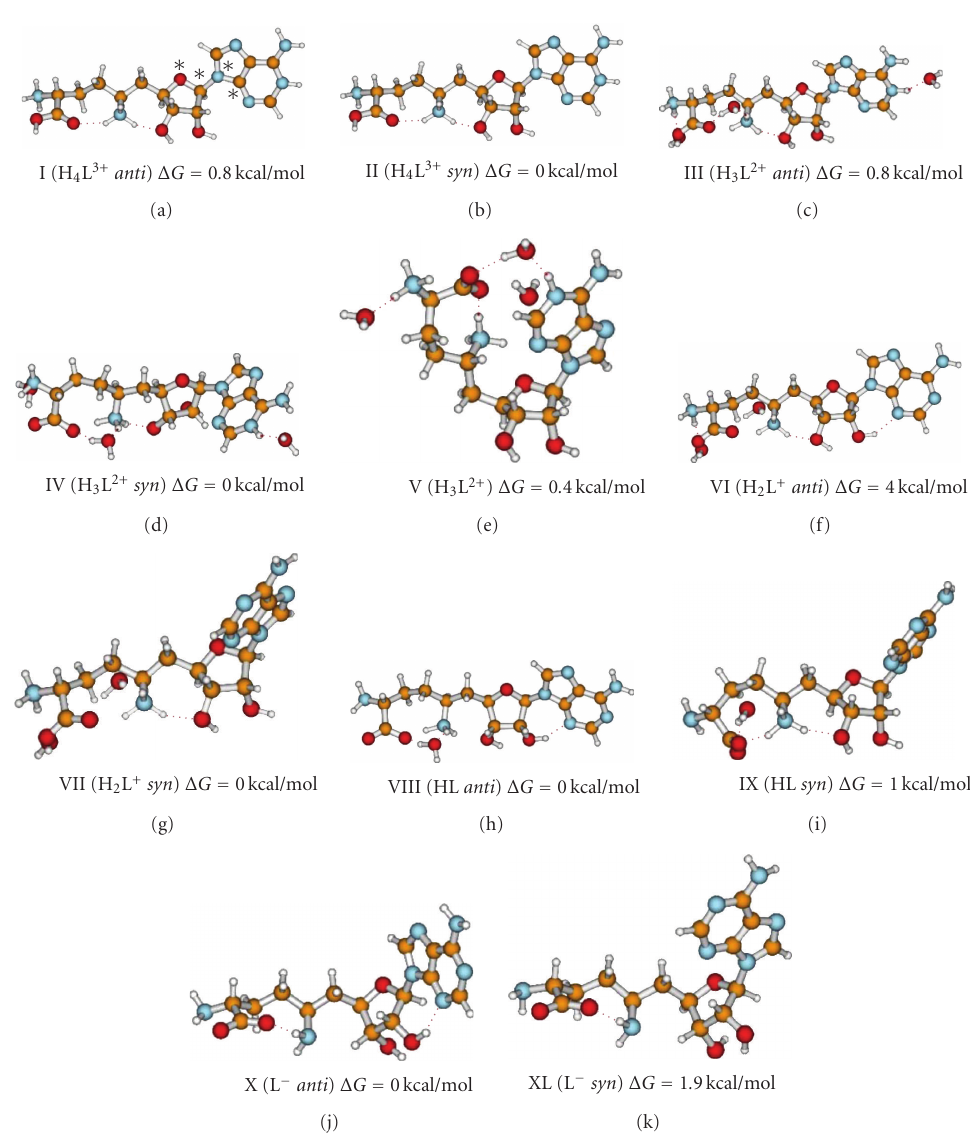
Figure 2: Conformations of free SFG molecule in various protonation states. The rotation angle of adenine is marked with asterisks.